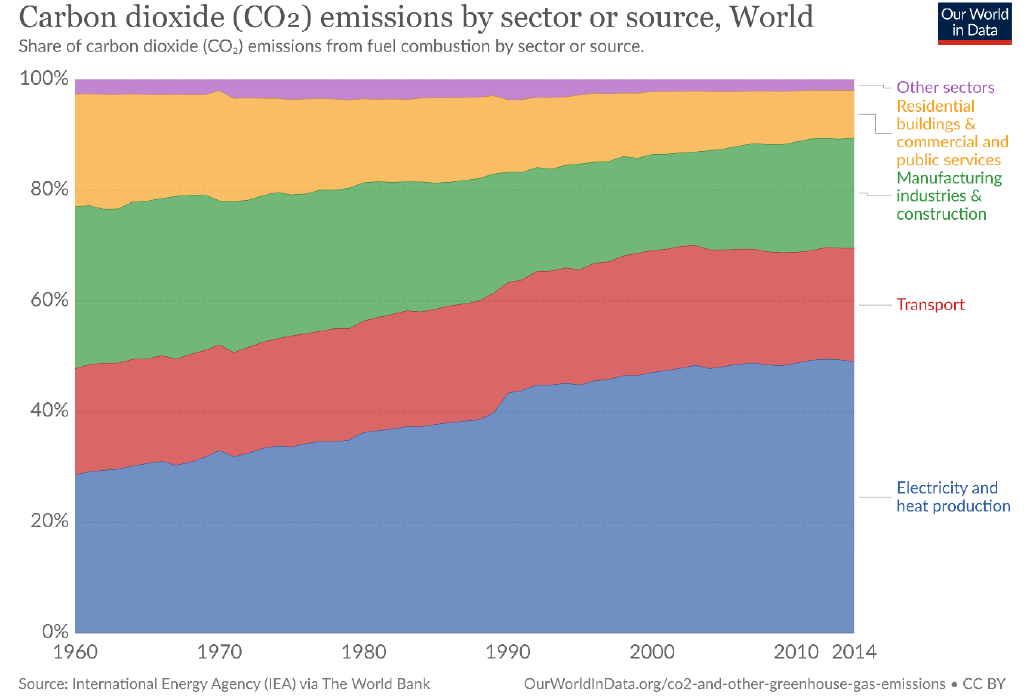
Fig. 1. Global CO2 emission distribution according to sources.